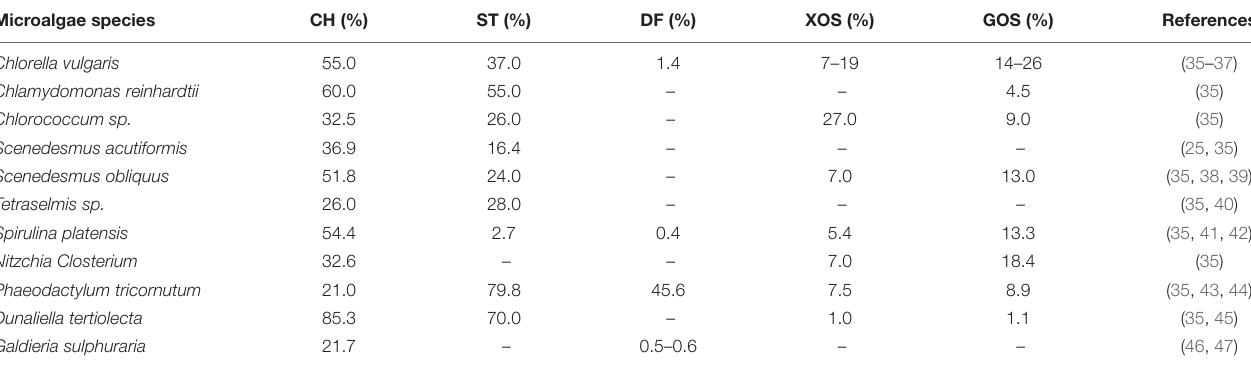
TABLE 3 | The different percentages of carbohydrate (CH), starch (ST), dietary fiber (DF), xylooligosaccharides (XOS), and galactooligosaccharides (GOS) originated from different microalgae